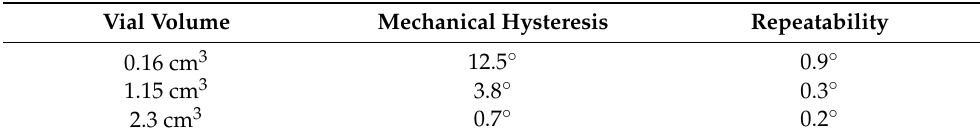
Table 2. Performance of the mercury tilt sensors.